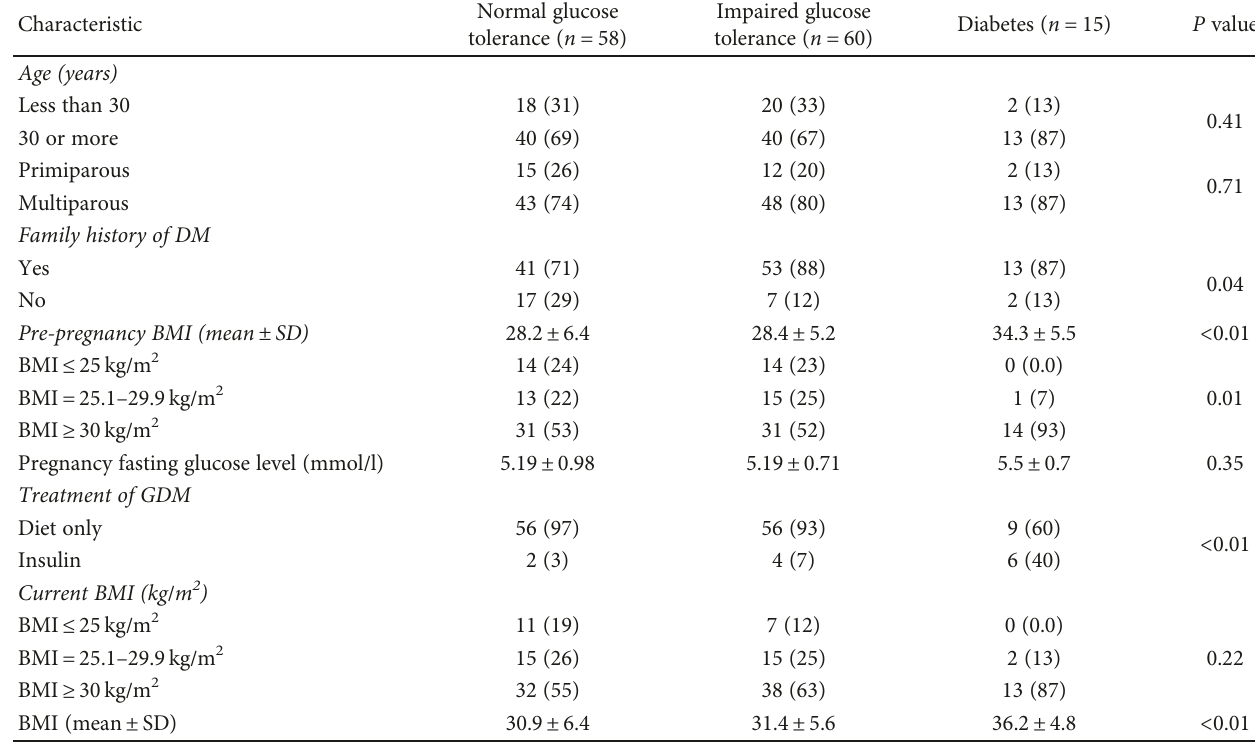
Table 1: Comparison of the characteristics of women with previous gestational diabetes who developed impaired glucose tolerance/diabetes and women who remained normoglycemic.